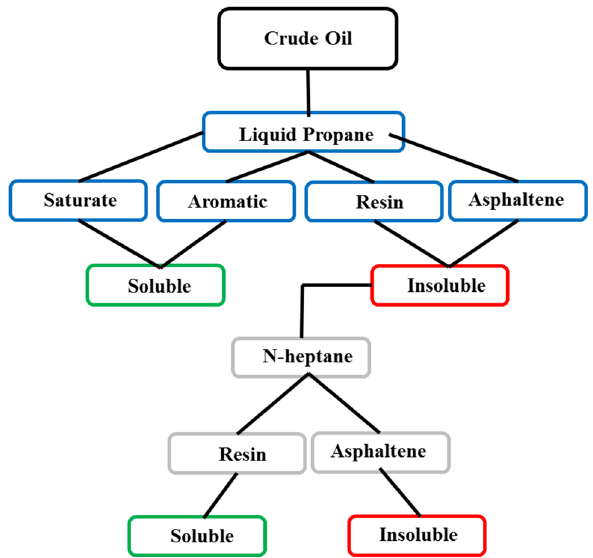
Fig. 5 SARA analysis